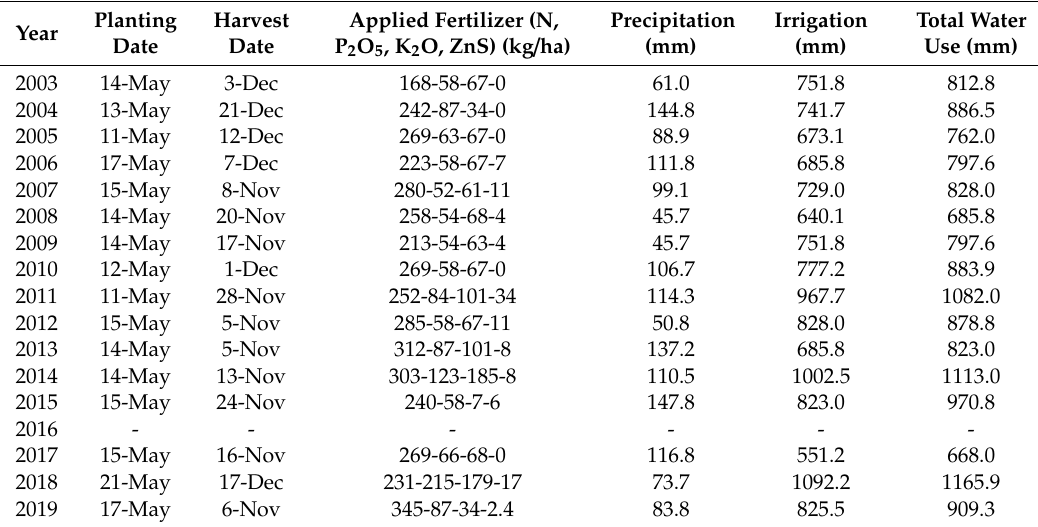
Table 2. Planting date, harvest date, applied fertilizer and the total water use for each maize growing season for the study